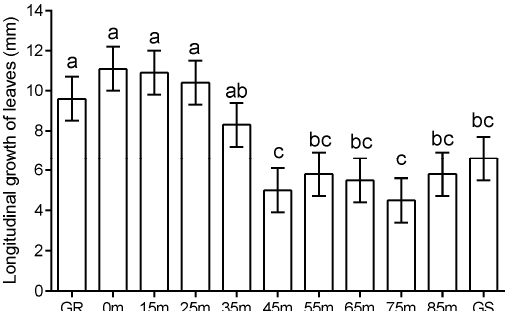
Figure 5. Glyphosate effects on longitudinal growth of leaves of the progeny of pollen receptor plants (spaced from 0 to 85 m from the glyphosate-resistant plants as the source of pollen), glyphosate-resistant plants (GR, positive control) and isolated glyphosate-susceptible plants (GS, negative control). Bars indicate mean values, error bars represent ± 1 standard error, and bars with the same letters are not significantly different ( p > 0.05; Tukey’s HSD